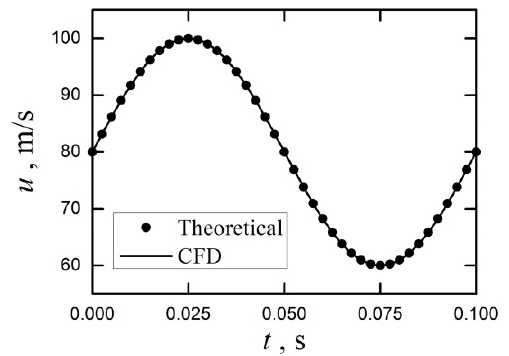
Figure 15. Comparison of the horizontal gust velocity between the theoretical value and the current CFD